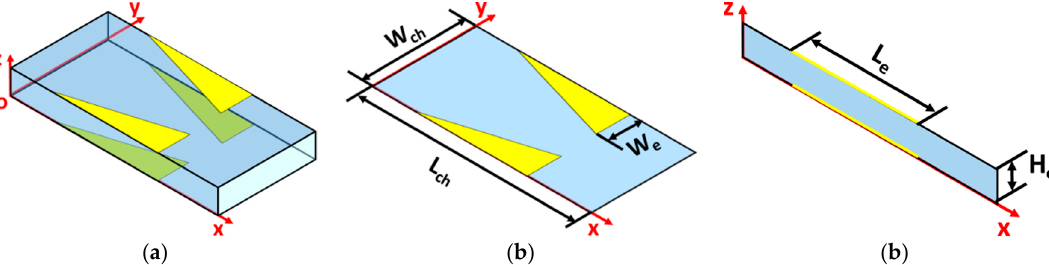
Figure 2. Schematic of the electrode configuration for dielectrophoresis (DEP)-based three dimensional (3D) focusing analyzed in this article ( a ) perspective view, ( b ) top view, and ( c ) side view.